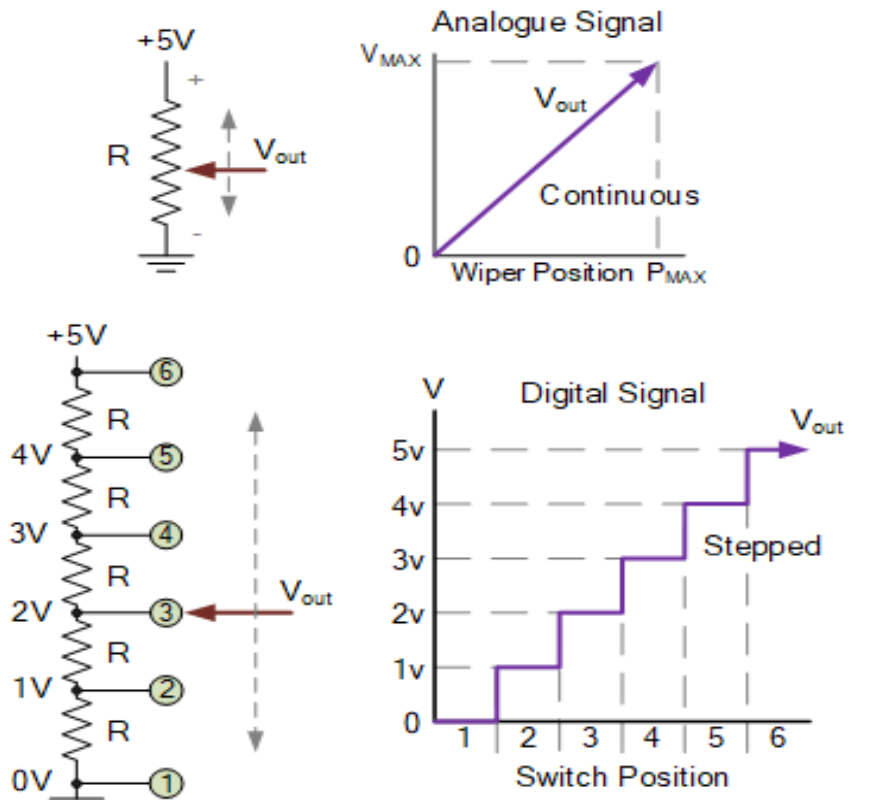
Figure 9. ADCs working for smart sensors based solar powered system.